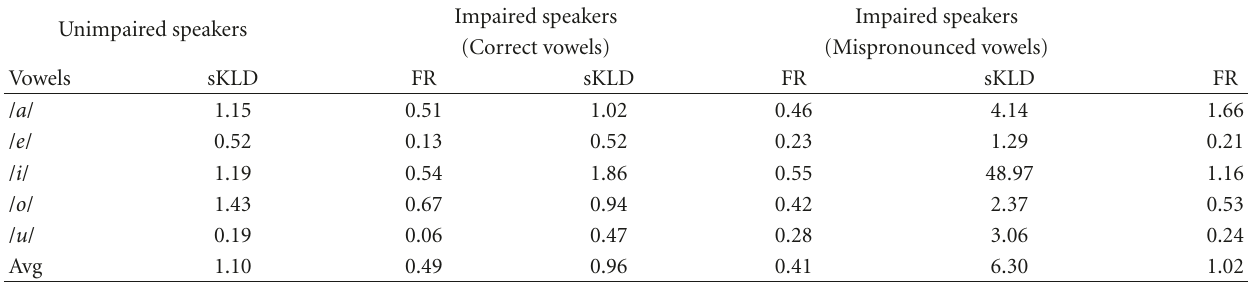
Table 14: sKLD and FR in pitch between stressed and unstressed vowels (Avg is the weighted average over the number of appearances of every